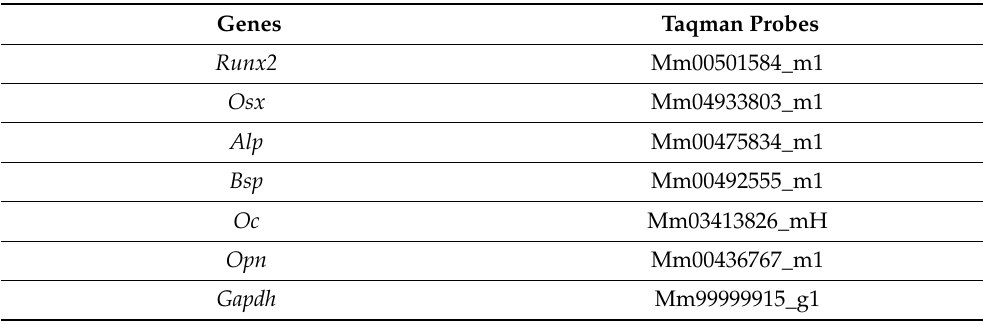
Table 2. TaqMan probes used in real-time PCR